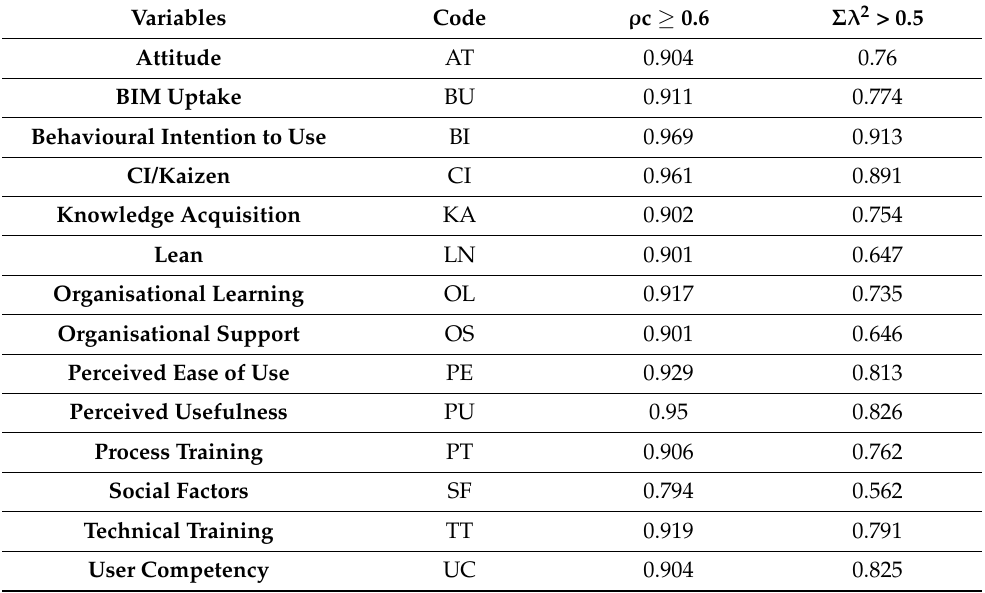
Table 3. AVE and composite reliability